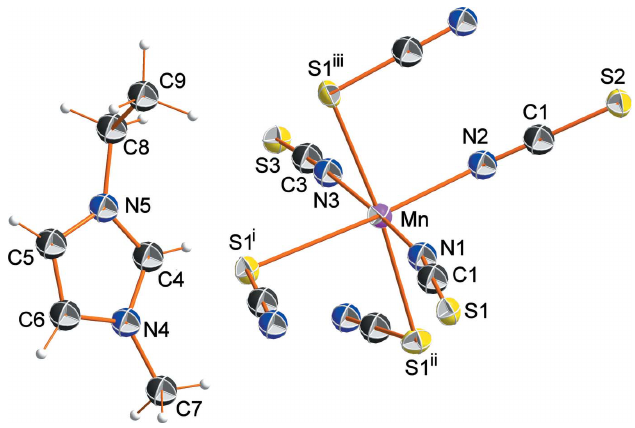
Figure 1 A view of the molecular structure of the octahedrally coordinated [Mn(NCS) 3 (SCN) 3 ] (cid:2) units of the polymeric complex anion and the EMIm + cation of the title compound, with the atoms being presented as 50% displacement ellipsoids. Symmetry codes: (i) 1 (cid:2) x , 1 (cid:2) y , 1 (cid:2) z ; (ii) x ,